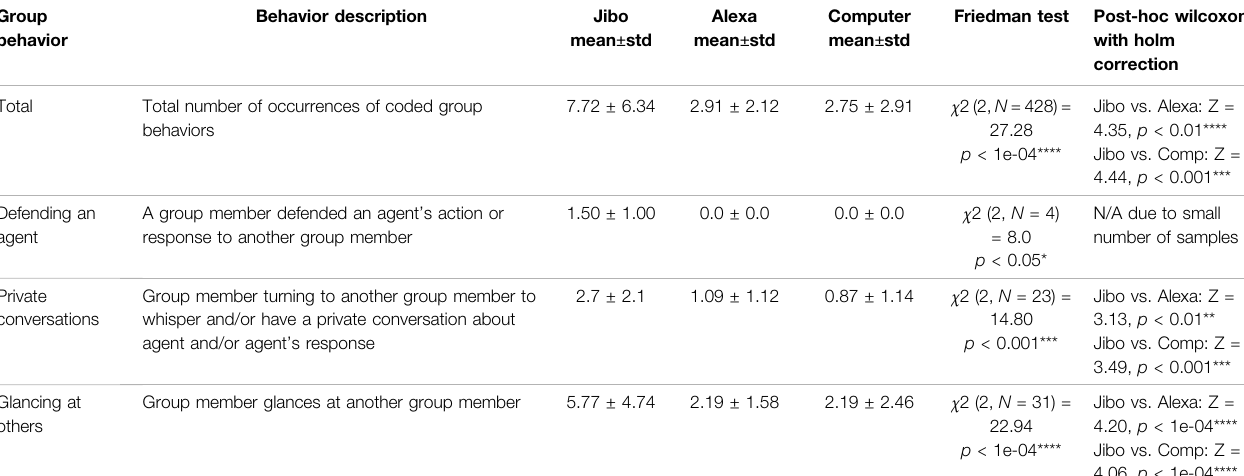
TABLE2| ComparinggroupbehaviorsobservedaroundthethreeVUIagentsthatvaryinthedegreeofsocialembodiment.Theoverallresultacrossthecombinedbehaviors and subsequent three behaviors showed statistically signi fi cant difference between the agents. Group behavior